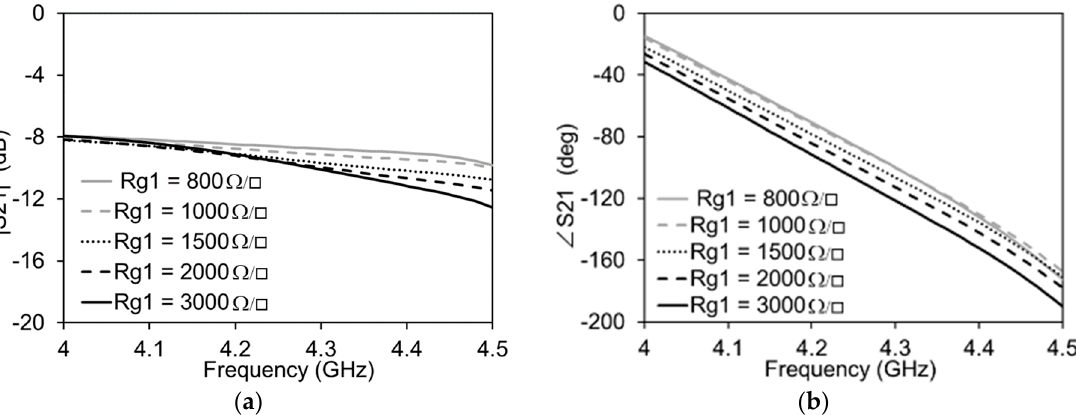
Figure 5. Simulations of the phase shifter mode of the transmission line with Rg = 3000 Ω / (cid:3) for all cases: ( a ) Amplitude variation; ( b ) Phase variation.